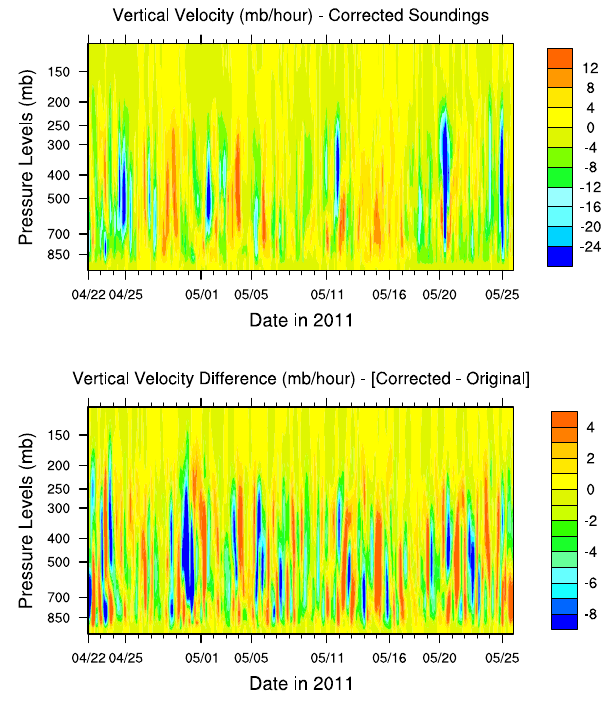
Figure 12. Comparison of large-scale forcing data set for original and corrected soundings. Derived large-scale vertical velocity using quality-controlled, humidity-corrected radiosonde profiles (top) and the difference (corrected-original) between the derived large-scale forcing using the corrected soundings and the original soundings. Please note that dates are given in month/day